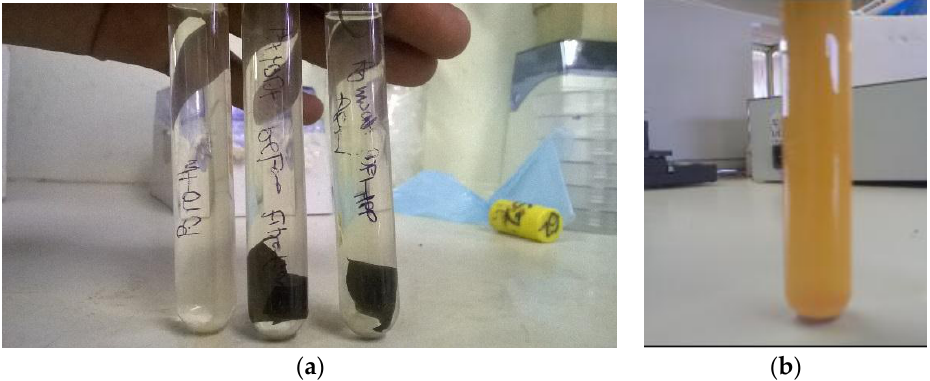
Figure 10. Demonstration of bactericidal property of Ag-MWCNTs/PVDF-HFP membrane in ( a ) nutrient broth media and ( b ) growth of E. coli bacteria in nutrient broth medium.